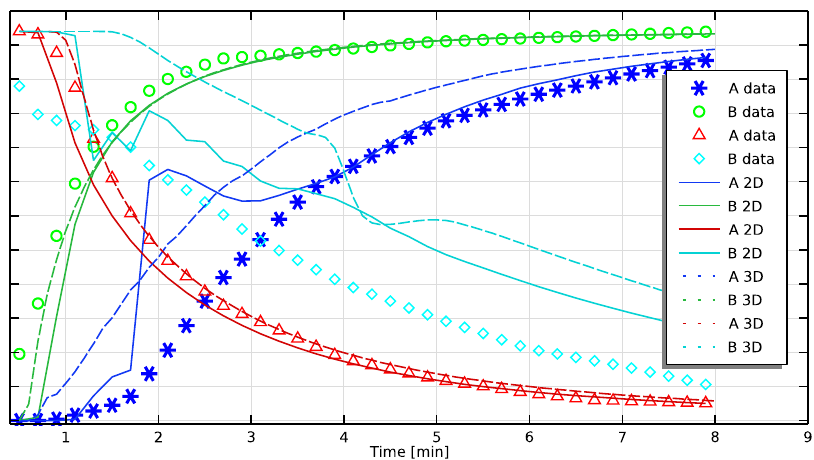
Figure 9. Comparison between measurements and numerical results, at two observation points, A and B, for the heating and cooling stages, for T 0 = 22 °C and T 1 = 95 °C with variable viscosity.